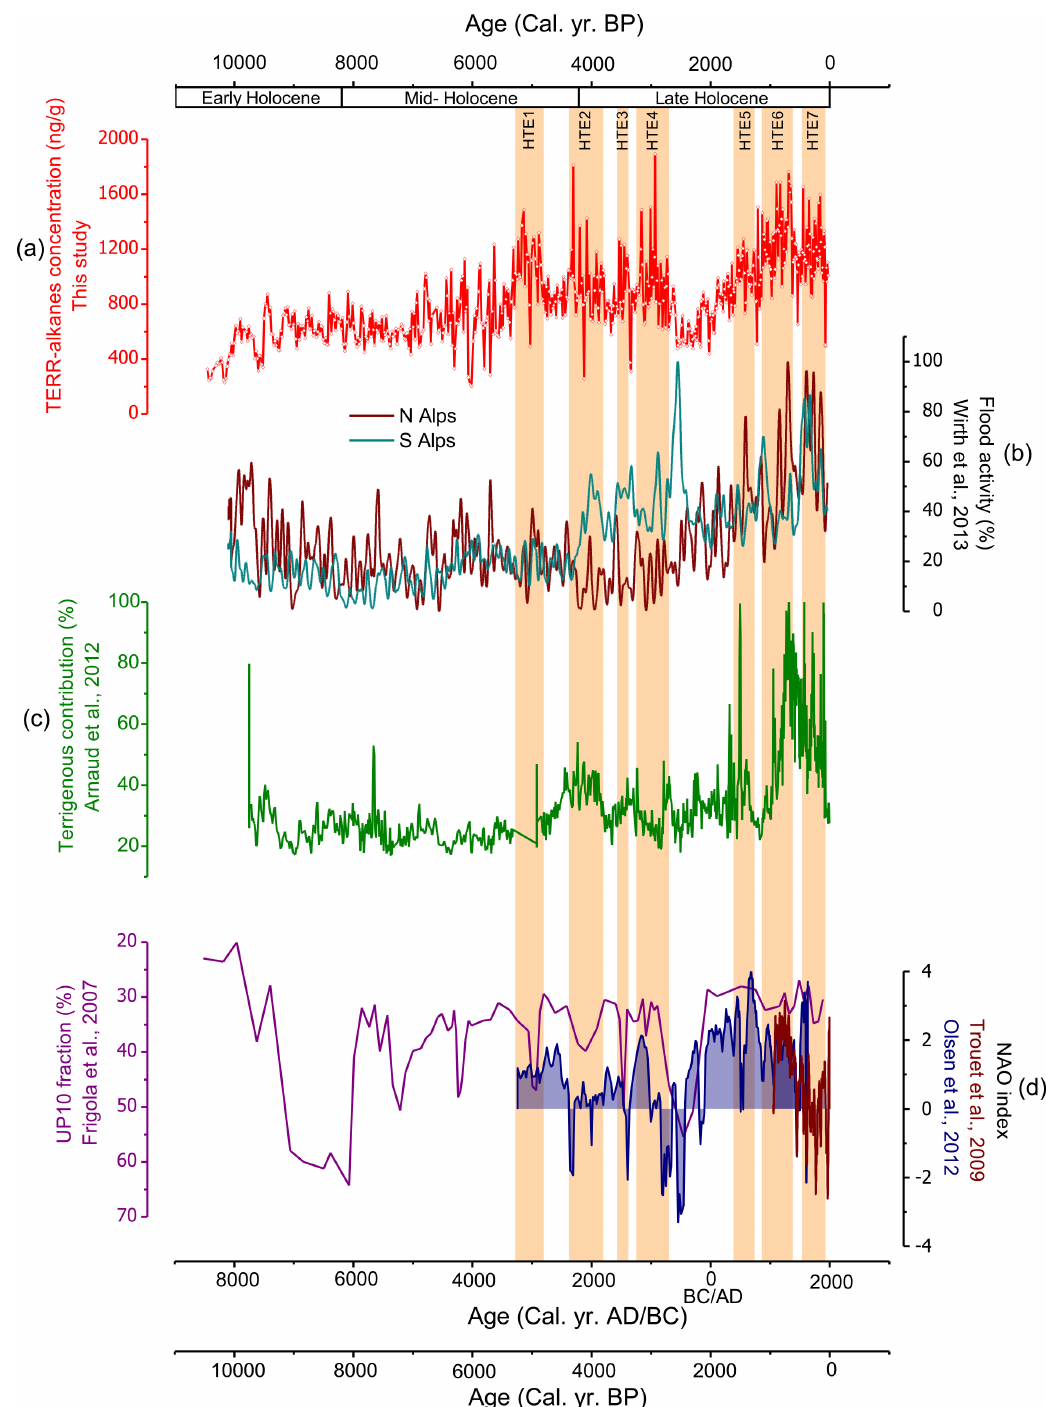
Figure 4. Holocene flood changes in the NW Mediterranean Sea and Alps region. (a) TERR-alkane abundances as a proxy of flood intensity. (b) Flood activity in the North and South Alps (from Wirth et al., 2013). (c) Total terrigenous fraction (%) indicates the Rhone river discharge into lake Bourget (Arnaud et al., 2012) (green curve). (d) The UP10 fraction from core MD99-2343 (Frigola et al., 2007; purple curve) and the winter-NAO index from Trouet et al. (2009; in red) and Olsen et al. (2012; in blue). Vertical light brown bars indicate the periods of high flood intensity based on the high TERR-alkane